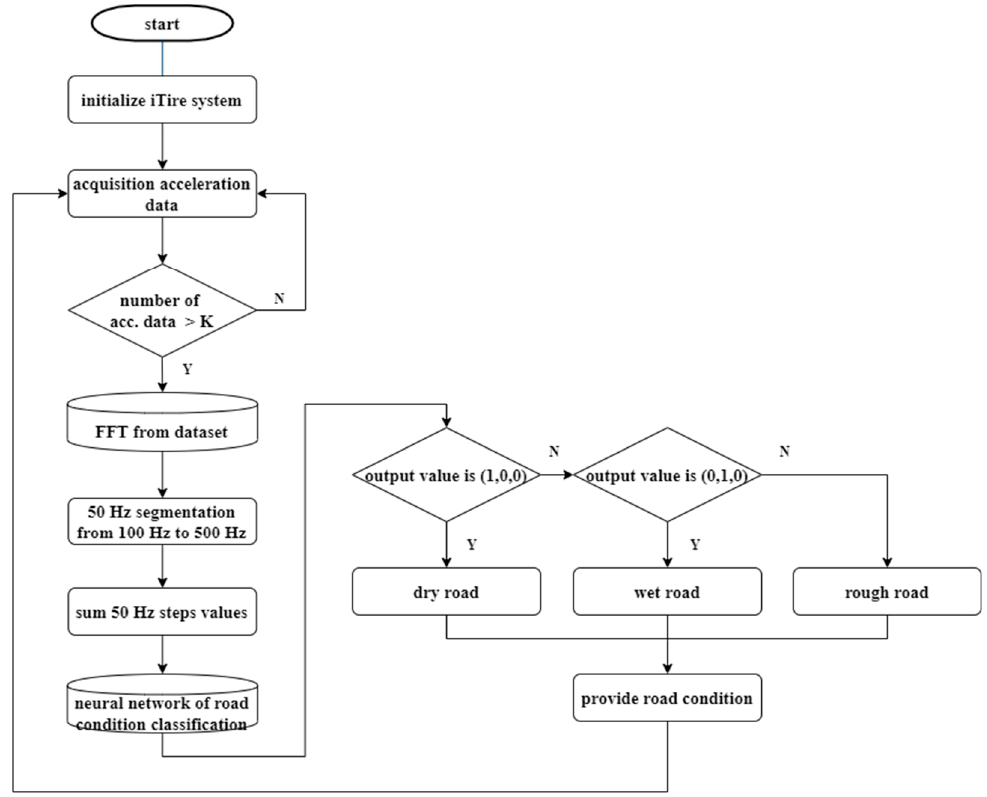
Figure 2. Road Condition Classification Algorithm of the iTire System.